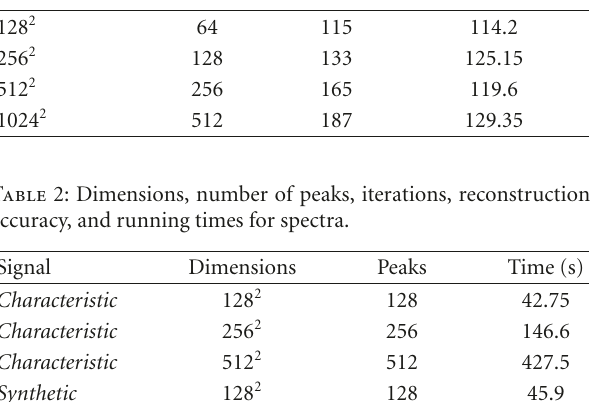
Table 1: Comparable undersampling factors for di ff erent sampling patterns.